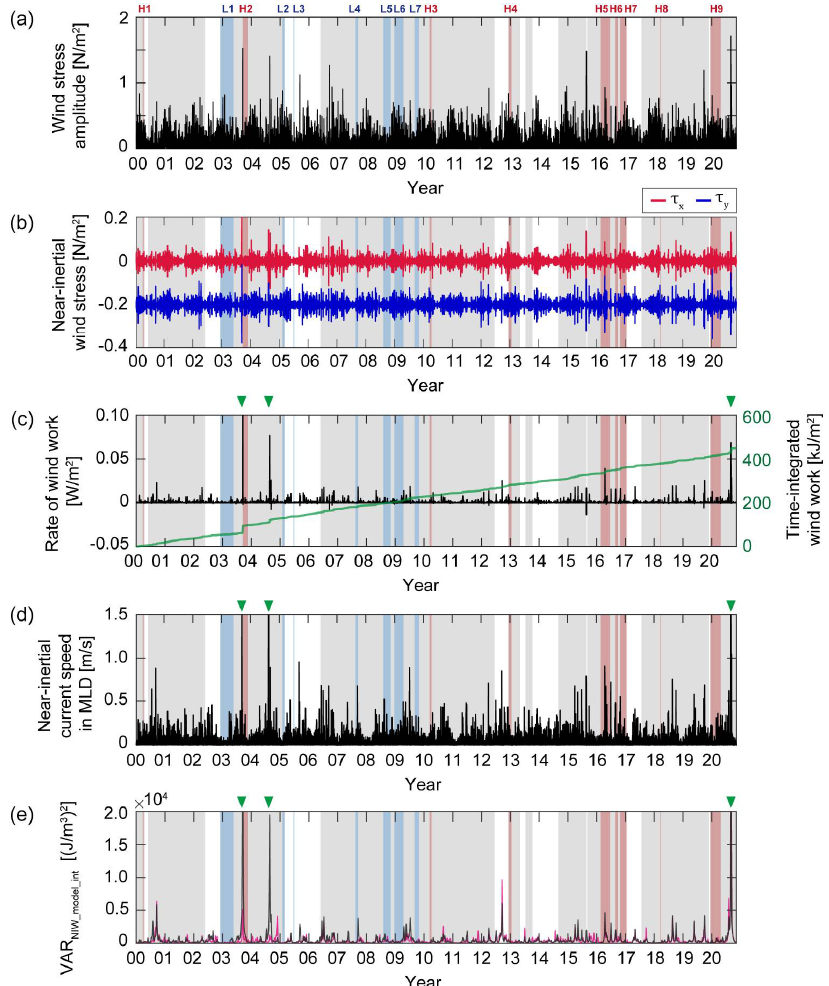
Figure 8. Time series of ( a ) wind stress amplitude, ( b ) near-inertial band-passed zonal (red) and meridional (blue) wind stresses, ( c ) rate of wind work Π (left axis) and time integral of Π showing cumulative wind energy input to the mixed layer (green solid line, right axis), ( d ) mixed layer near-inertial current amplitude, (cid:112) u ML 2 + v ML 2 , calculated from the damped slab model, and ( e ) intraseasonal-band variance of ( d ) from local (black) and remote (pink) wind stresses where the latter denotes wind stress averaged over 38–40 ◦ N. Red (blue) shaded boxes indicate period high (period low). Grey shaded area indicates period neutral. Green triangles in ( c – e ) indicate the periods when the mixed layer near-inertial current amplitude was larger than 1